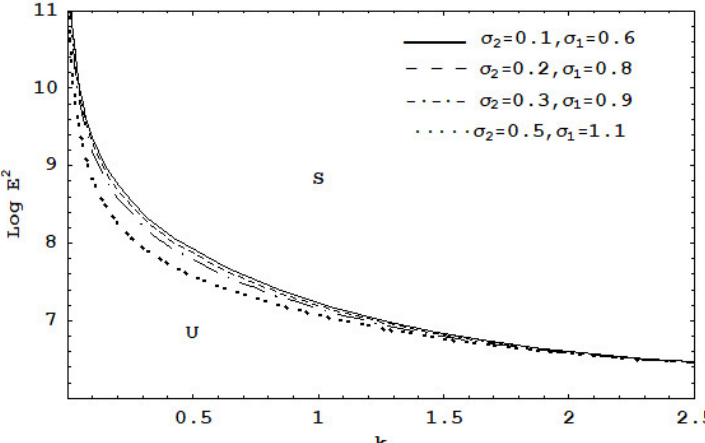
Figure 2. Variation of the electric field intensity log E 2 electrical conductivities σ 1 , ( σ 2 = 0.1 ) .